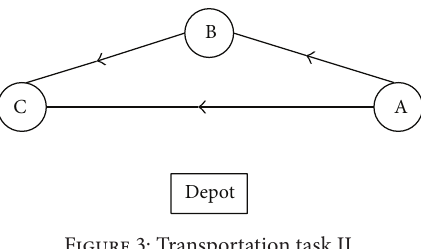
Figure 3: Transportation task II.